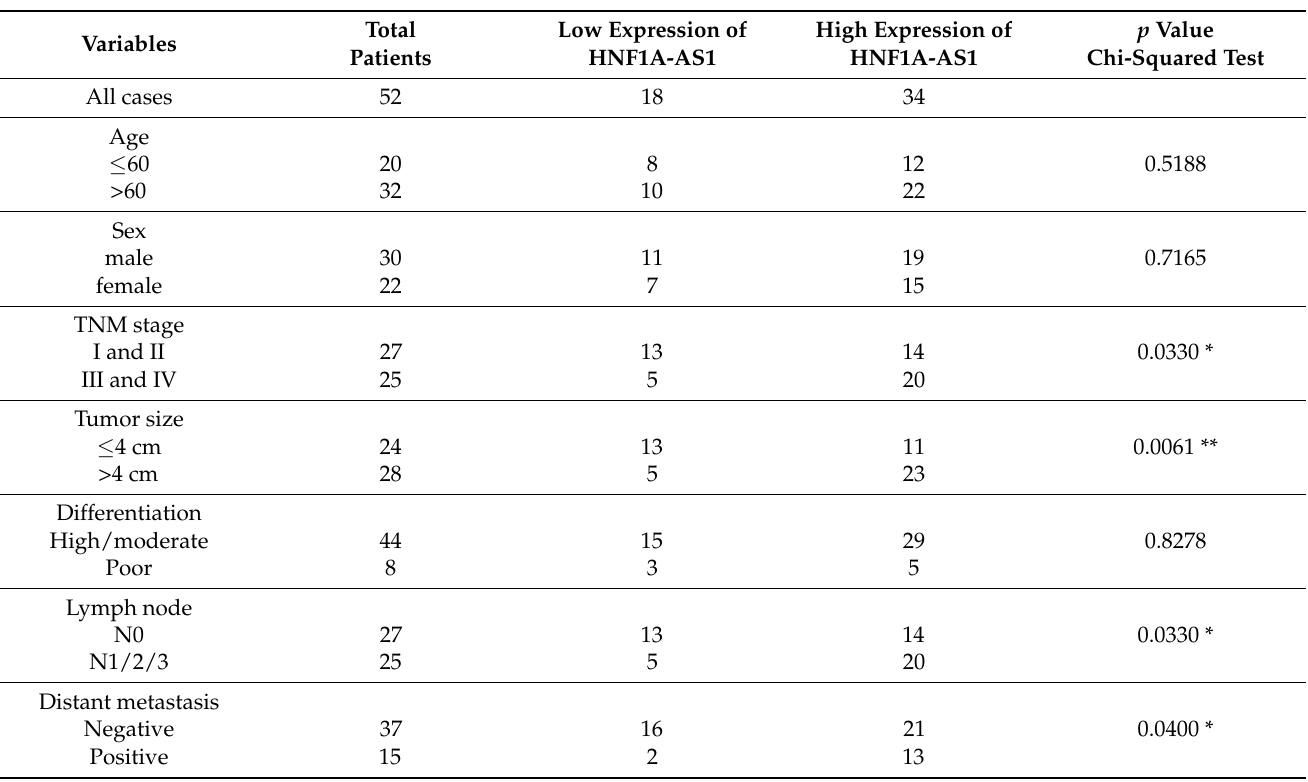
Table 1. Correlation between HNF1A-AS1 expression and clinicopathological characteristics of 52 CRC